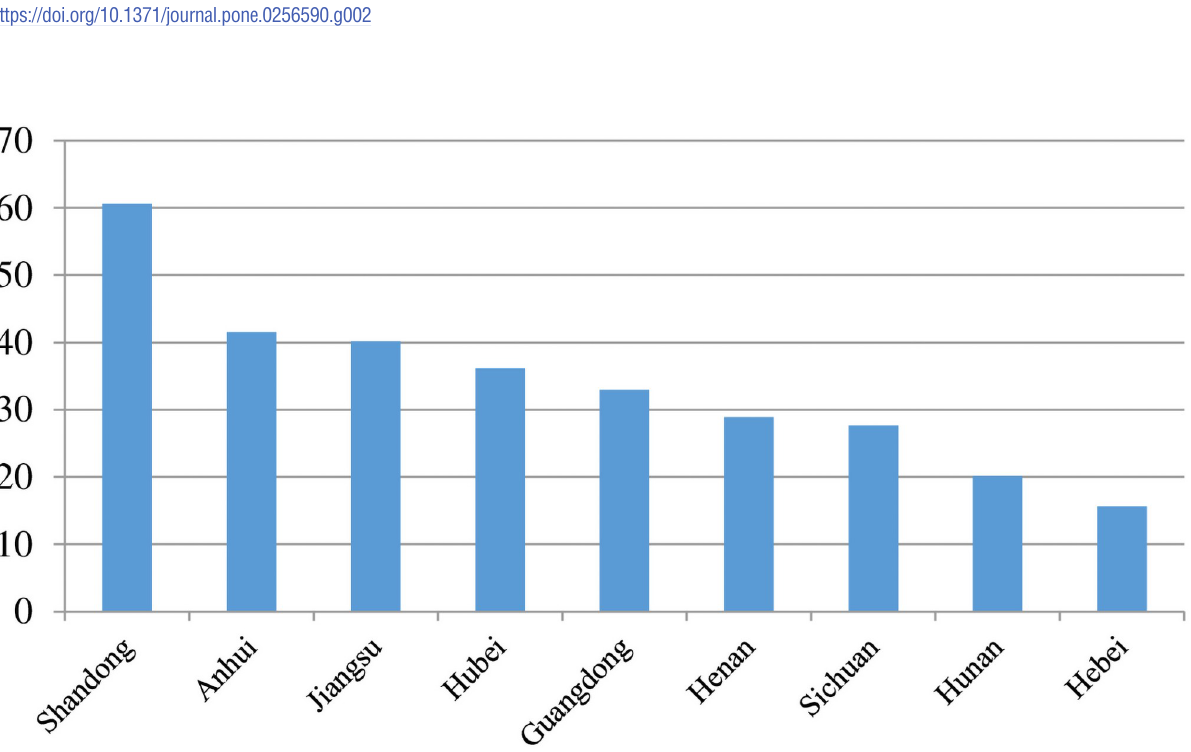
Fig 3. Gross grain output value of China’s provinces (top 9) in 2007. Unit: Billion dollars. Data source: China’s National Bureau of Statistics (CNBS) 2007.